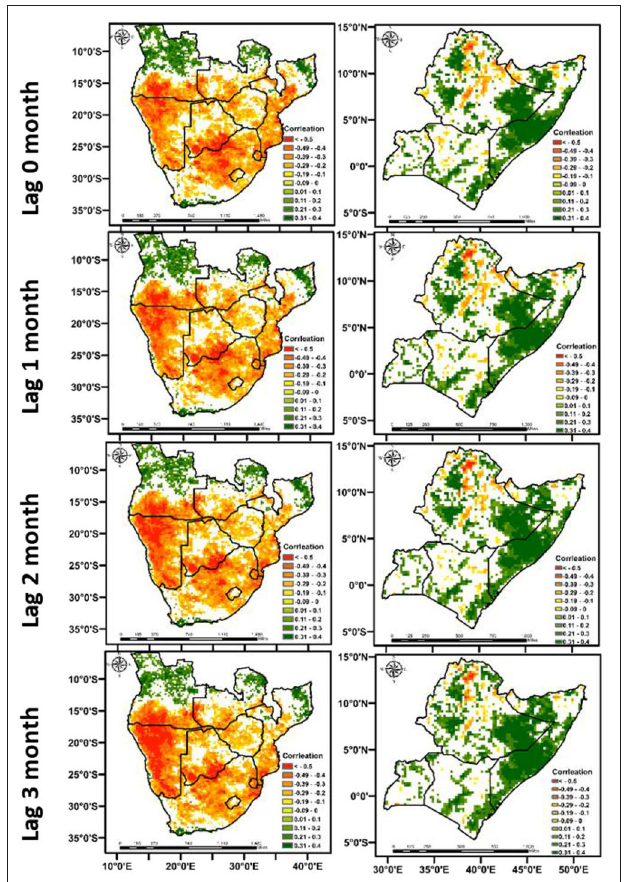
FIGURE 1 | Correlation between ENSO and standardized NDVI anomalies over Southern Africa and Eastern Africa for the period of 2010–2019. The white areas are the pixels for which the correlation is not significant at the 90% level.